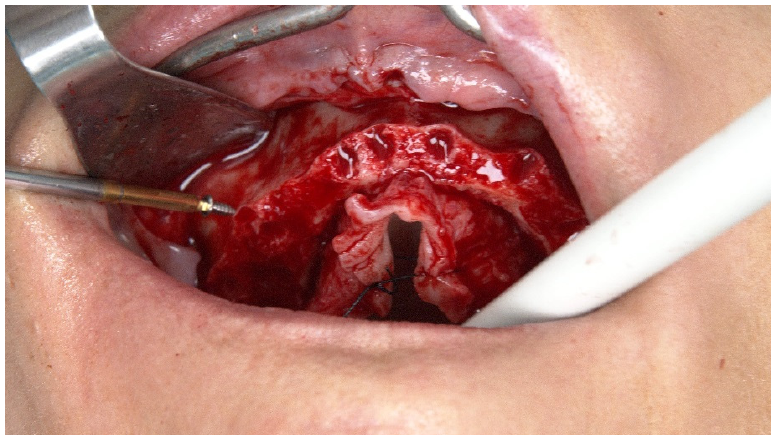
Figure 4. Perioperative intraoral photograph illustrating the insertion of the TriStar